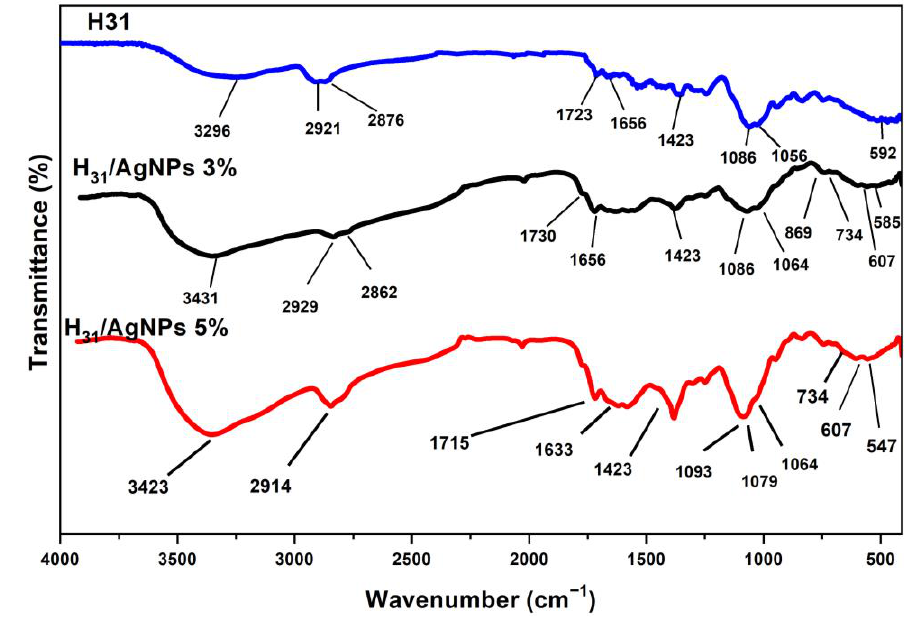
Figure 2. FTIR spectra of H 31 and its AgNP composites.